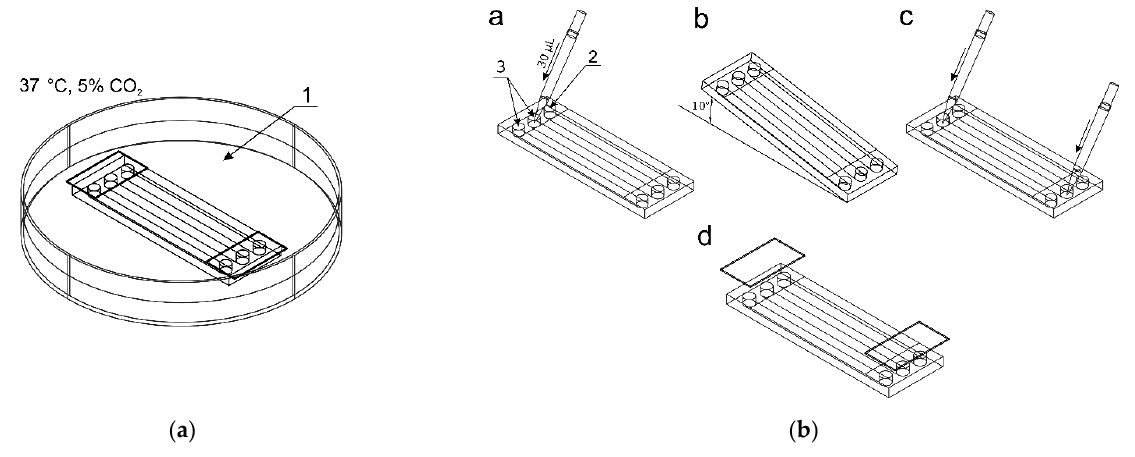
Figure 2. The procedure of seeding cells in chambers of the microfluidic device: ( a ) The microchip placed in a Petri dish with distilled water; ( b ) The seeding steps: a—adding a cell suspension to reservoirs of two culture chambers, b—directing the suspension to the chambers, c—final adding media, d—reservoirs protection.